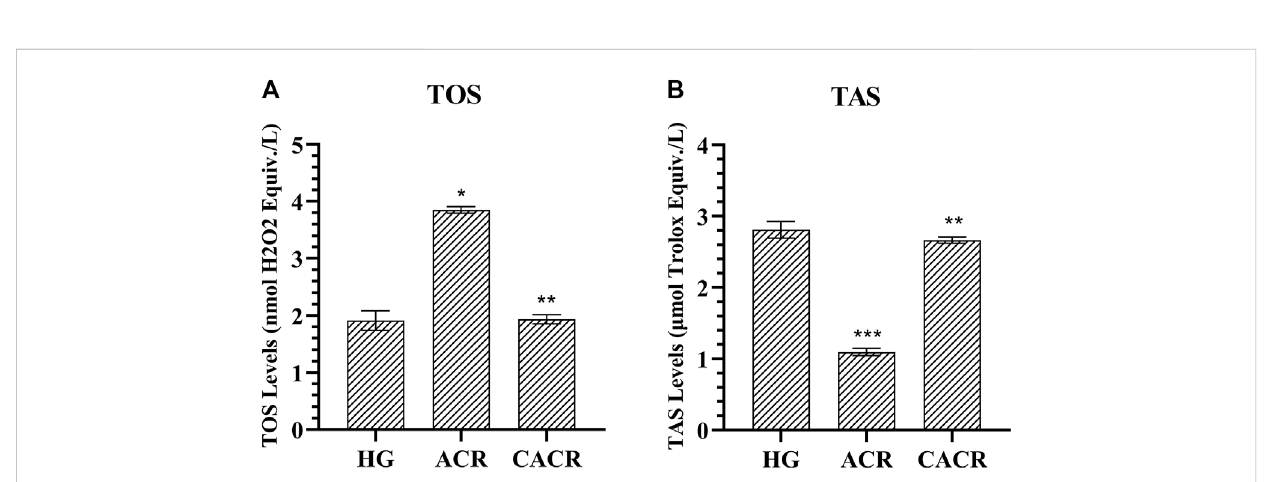
FIGURE 2 (A,B) Analysis of TOS and TAS levels in liver tissues of rats in experimental groups. n = 6/each group. The bars show the mean ± standard deviation. * p < 0.05, ACR group is compared with the HG and CACR groups. ** p > 0.05, CACR group is compared with the HG group. *** p = 0.001, ACR group is compared with the HG group.